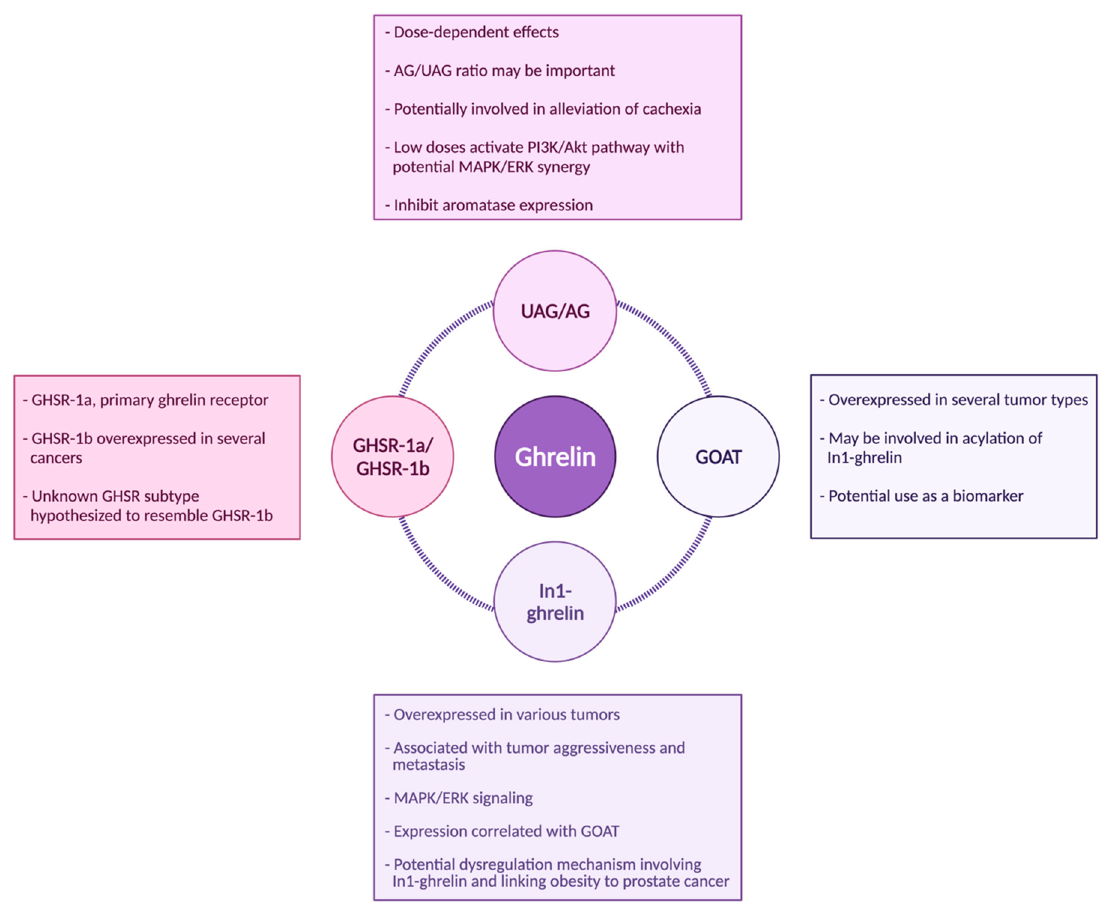
Figure 3. Summary of the proposed relationship between the ghrelin axis and cancer, highlighting the known and proposed roles of UAG, AG, In1-ghrelin, GHSR-1a, GHSR-1b, and GOAT. Author Contributions: Conceptualization, E.D.G. and Y.S.; literature review and writing, A.S.K. (Anuhya S. Kotta) and A.S.K. (Abigail S. Kelling); review and editing, all authors. All authors have read and agreed to the published version of the manuscript.